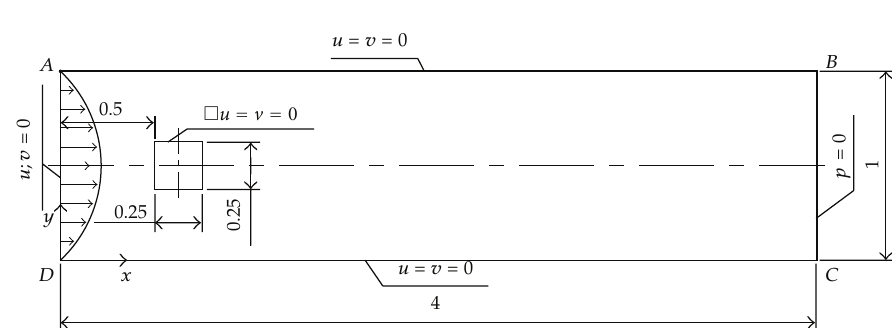
Figure 3: Flow field configuration and boundary conditions of flow around a square cylinder.